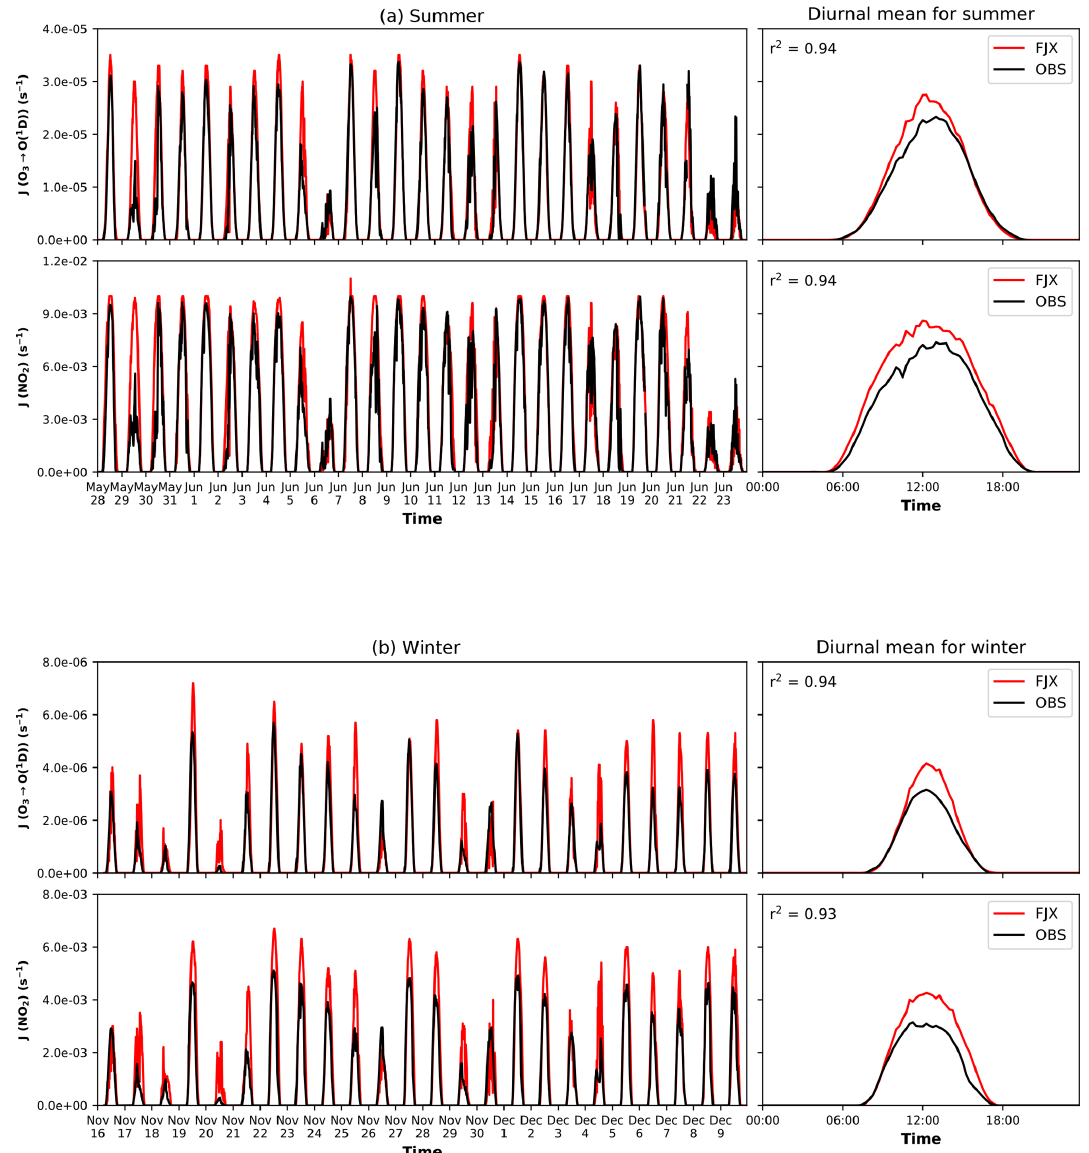
Figure 1. Modelled vs. observed photolysis rate constants for the winter (a) and summer (b) campaign periods. Time series (left-hand plots) and campaign diurnal averages (right-hand plots) of J [O 1 D] and J [NO 2 ] are shown for simulations with Fast-JX (FJX) including cloud and aerosol (red lines) and for observations. Note the difference in magnitude of rate constants between summer and winter. The r 2 values for modelled vs. observed hourly photolysis rates are shown in the right-hand plots for